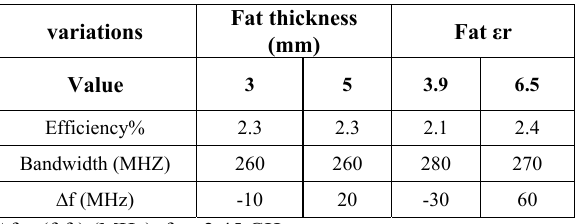
Table 1. Effects of variation of fat thickness and dielectric properties